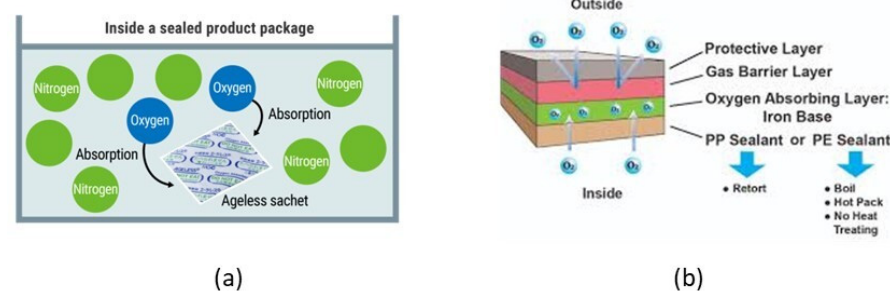
Figure 2. ( a ) Oxygen scavenger sachet, ( b ) oxygen scavenging film (ResearchGate)